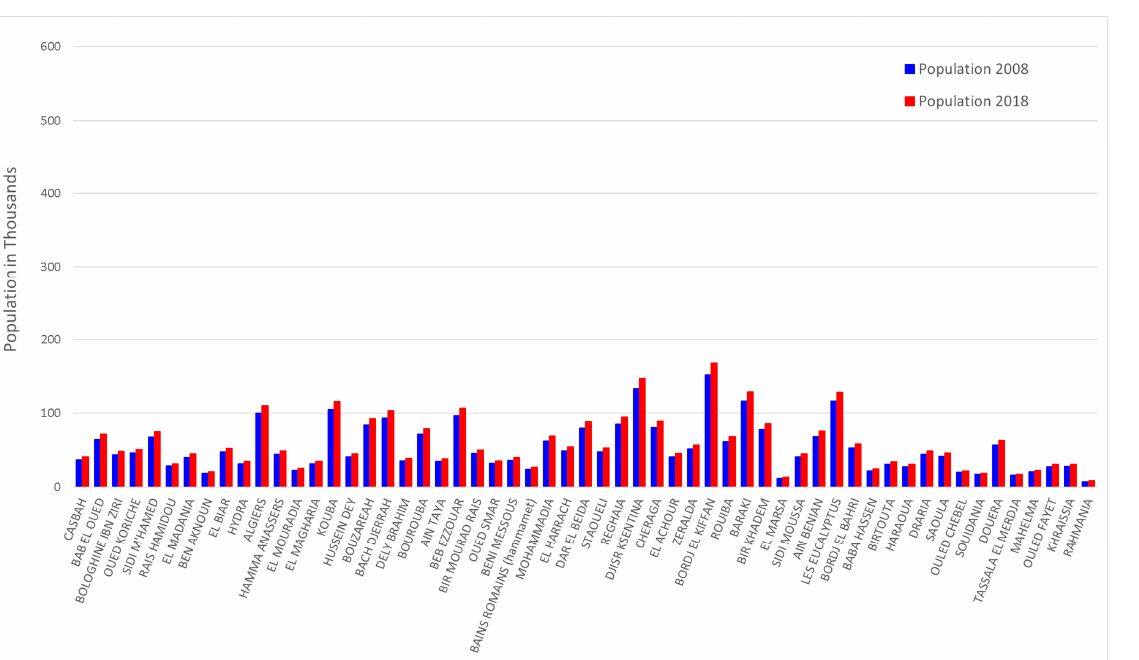
Figure 11. Difference of impervious surface area per capita (m 2 /person) for the communes in the Oran wilaya between 2008 and 2018.